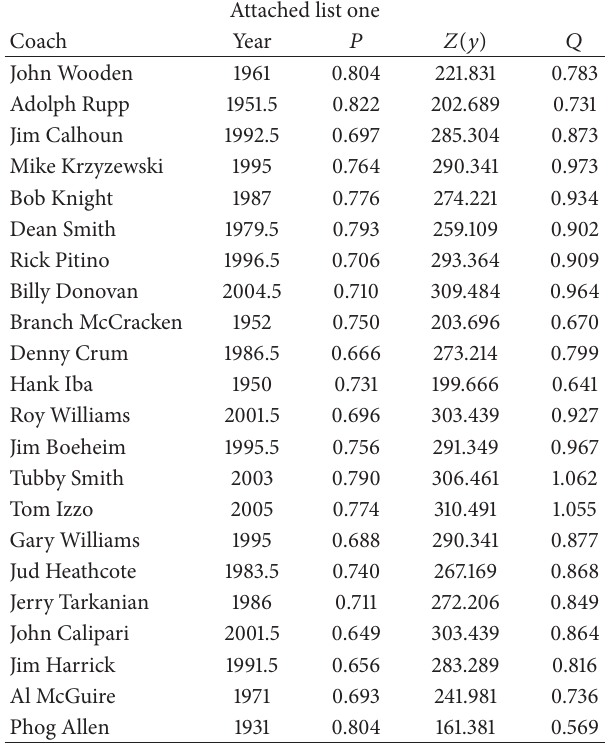
Table 3: Relevant data in optimization.